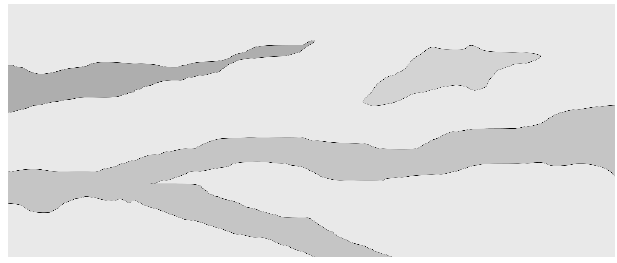
Figure 18. Reference XY-section of the stone block.